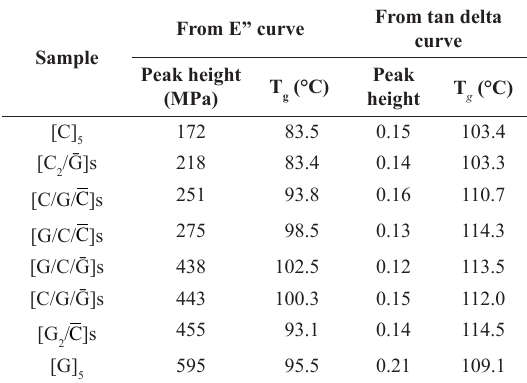
Table 3. Peak height and Tg obtained from E” and tan delta curves.